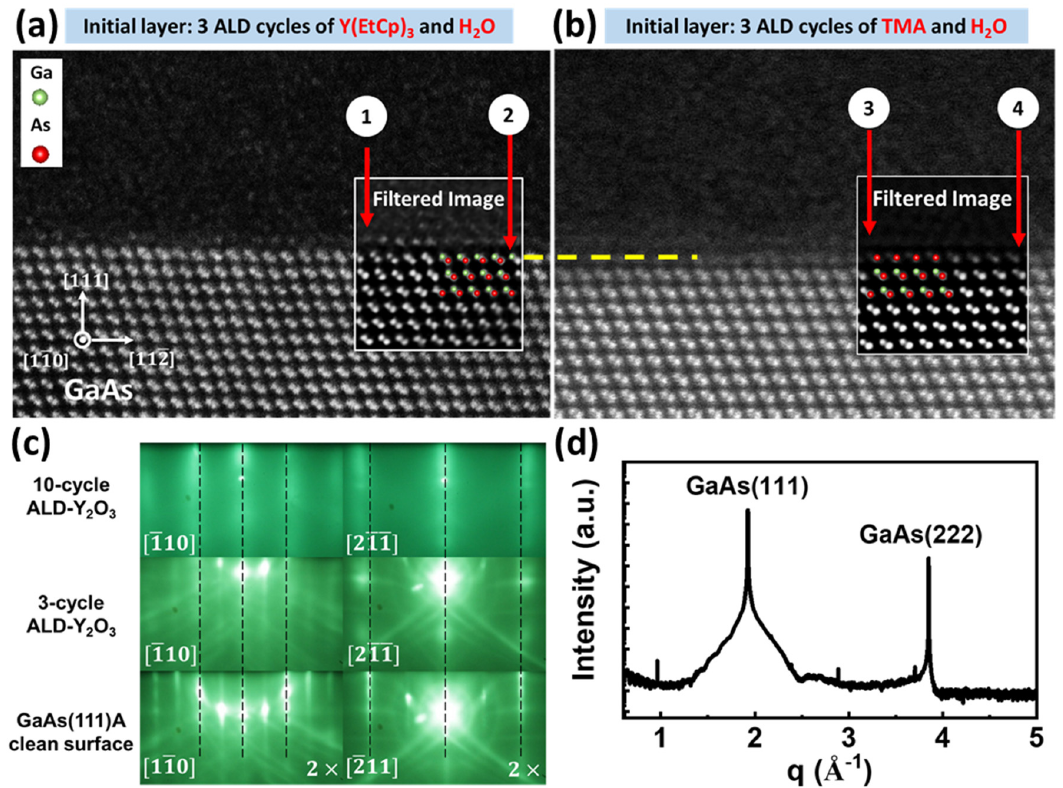
Figure 2. Cross-sectional HAADF-STEM images of ( a ) sample A and ( b ) sample B, as viewed along GaAs (cid:4670)11(cid:3364)0] zone axis, ( c ) RHEED patterns of epi GaAs(111)A, 3-cycle ALD-Y 2 O 3 , and 10-cycle ALD-Y 2 O 3 , and ( d ) SR-XRD specular scan of ( a ) sample A. A dashed yellow line marks the top GaAs layer and a model of GaAs stacking in green and red is overlaid in Figure 2a,b. Arrow (1) points out the ordered Y adatoms. Arrow (2) points out the GaAs(111)A surface with Ga on top. Arrow (3) points out that there is no observation of ordered Al or Y adatoms. Arrow (4) points out the top GaAs dumbbells with visible As.